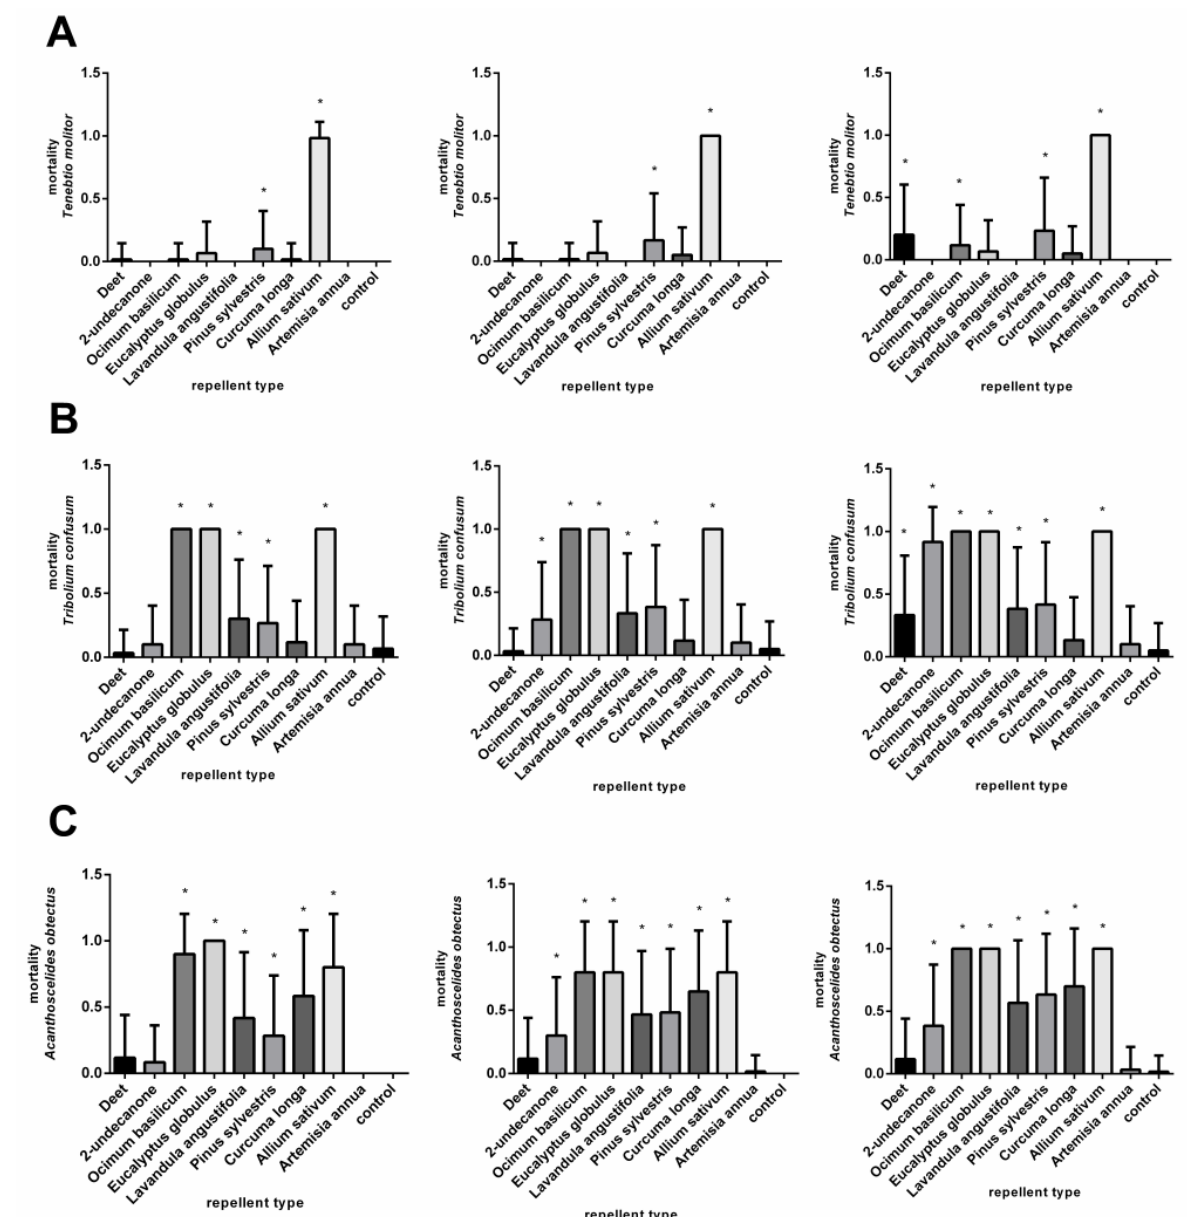
Figure 3. Mortality of Tenebrio molitor ( A ), Tribolium confusum ( B ), and Acanthoscelides obtectus ( C ) after using chemical products (DEET and 2-undecanone) and essential oils ( Ocimum basilicum , Eu- calyptus globulus, Lavandula angustifolia, Pinus sylvestris, Curcuma oblonga, Alium sativum, and Artemi- sia annua ) at a concentration of 0.37 µL/cm 2 in comparison to control group. Significant differences are marked with an asterisk (*). The order of the graphs determines the incubation time (24, 48, and 72 h) after application. Each column shows mean of dead individuals and SD.